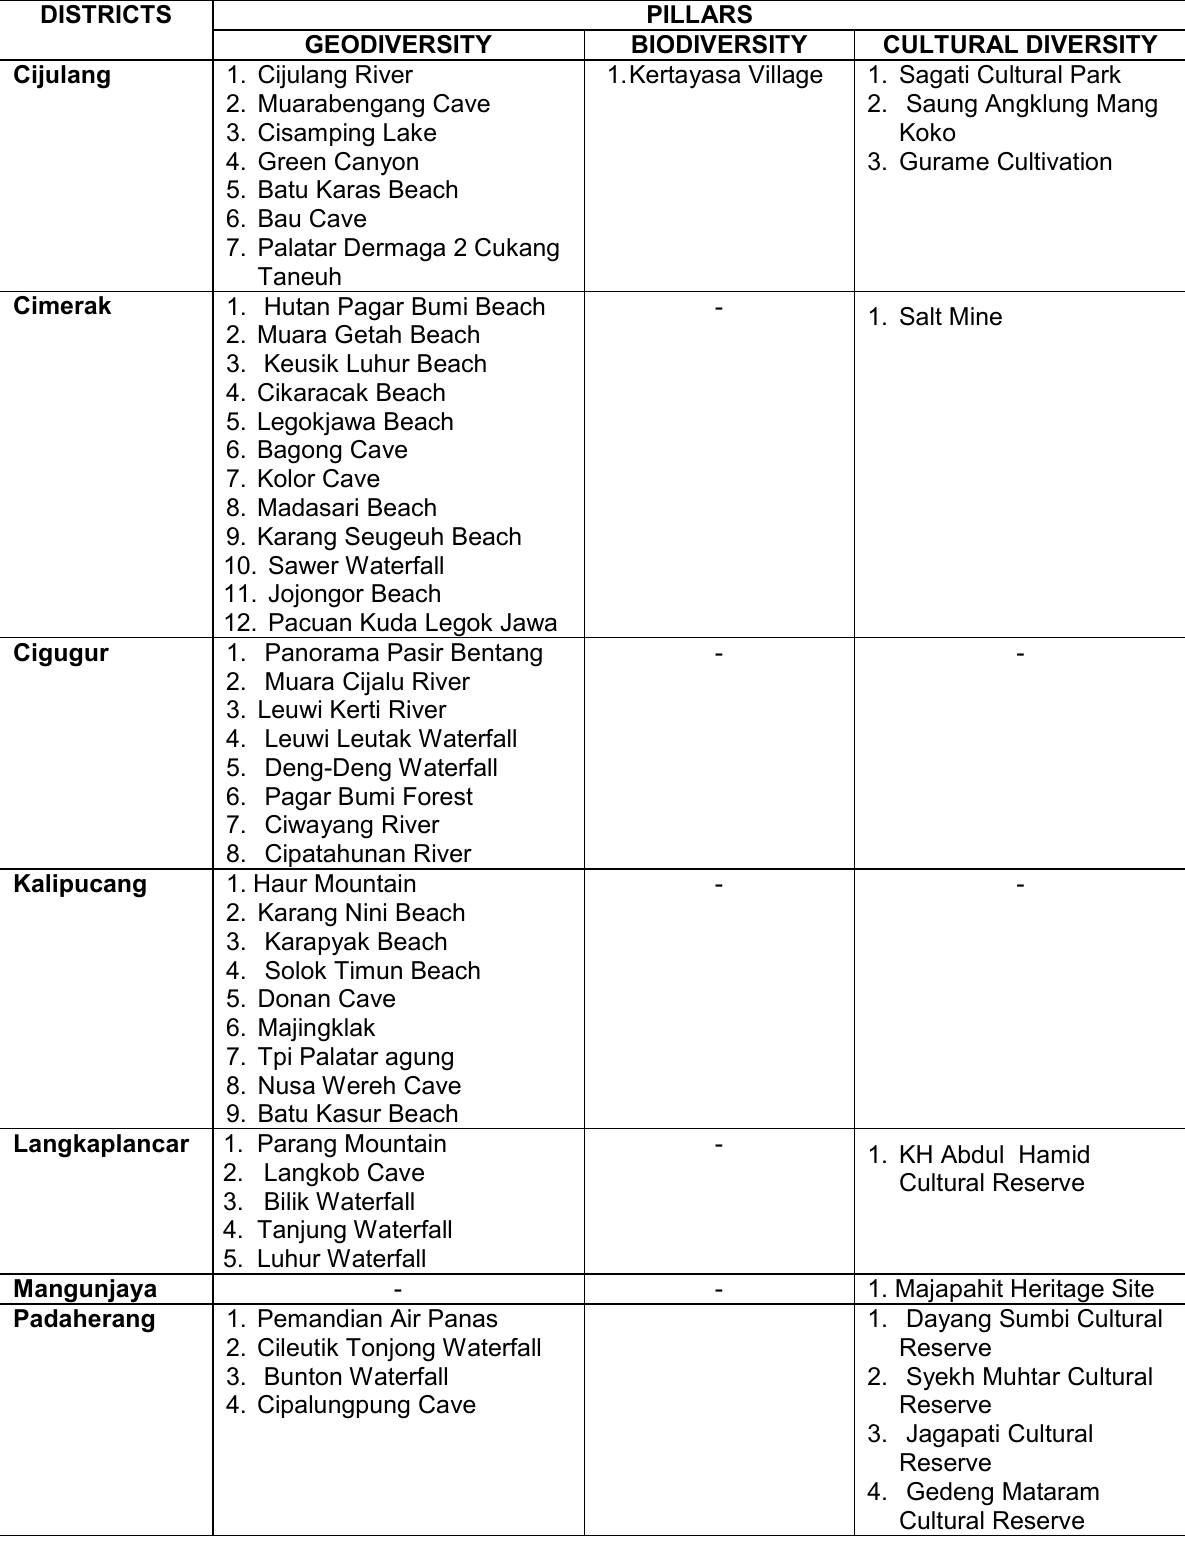
Table 1. Three Pillars of Aspiring Pangandaran